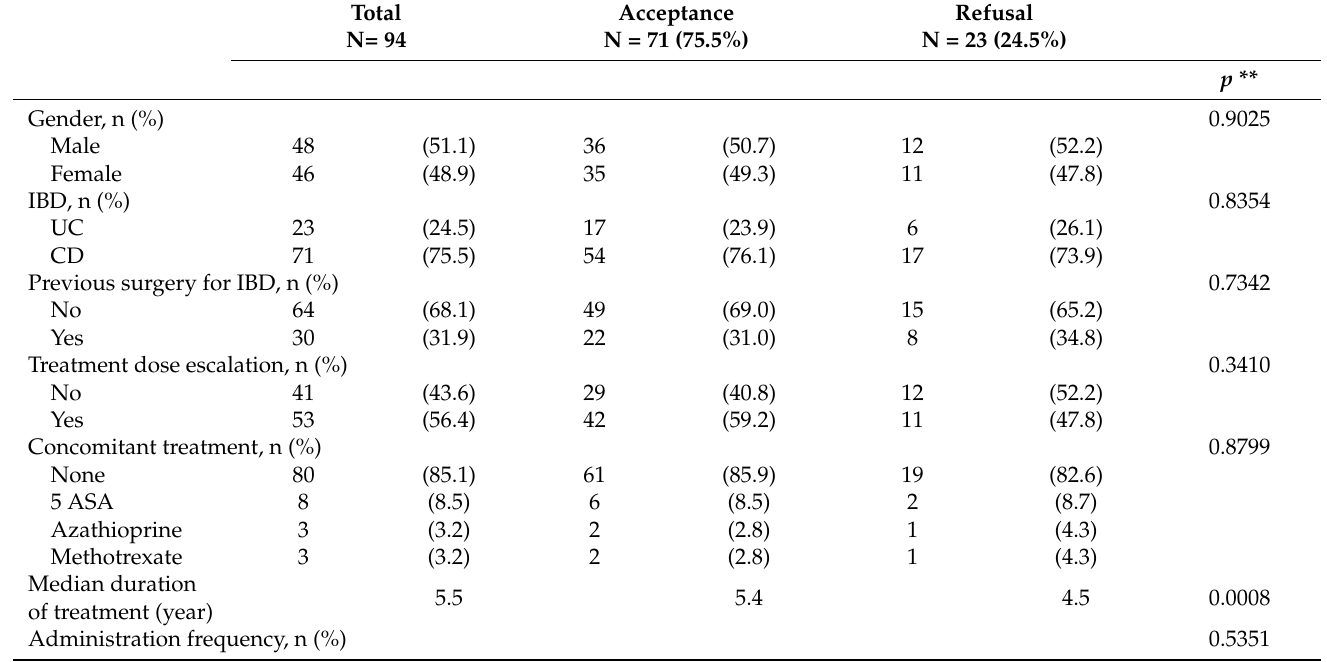
Table 5. Comparison of characteristics of patients treated with infliximab according to acceptance or refusal for